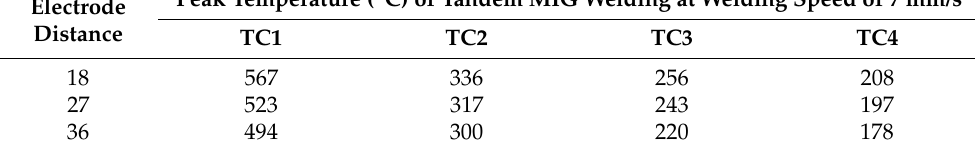
Table 3. Peak temperature in the thermal cycle (TC).